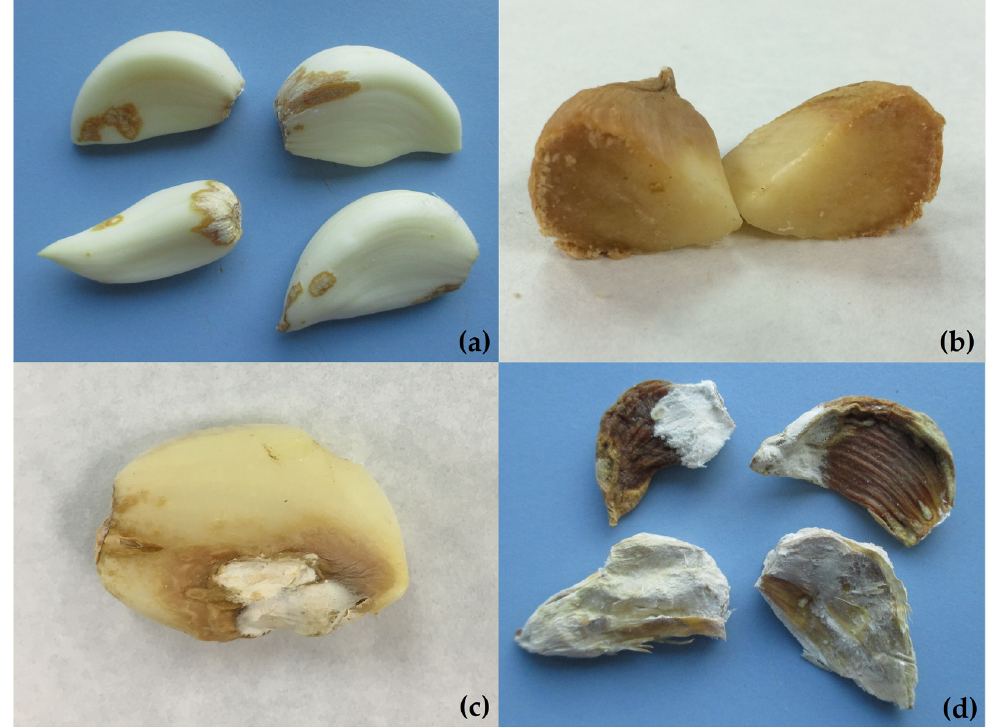
Figure 2. Different symptoms of rot in garlic cloves caused by F. proliferatum : ( a ) brown lesions with a dehydrated appearance in different zones of the garlic clove; ( b ) rot lesions penetrating the clove; ( c ) garlic clove with brown lesions and covered with white mycelia; ( d ) dry and wrinkled cloves in advanced stages of the disease.